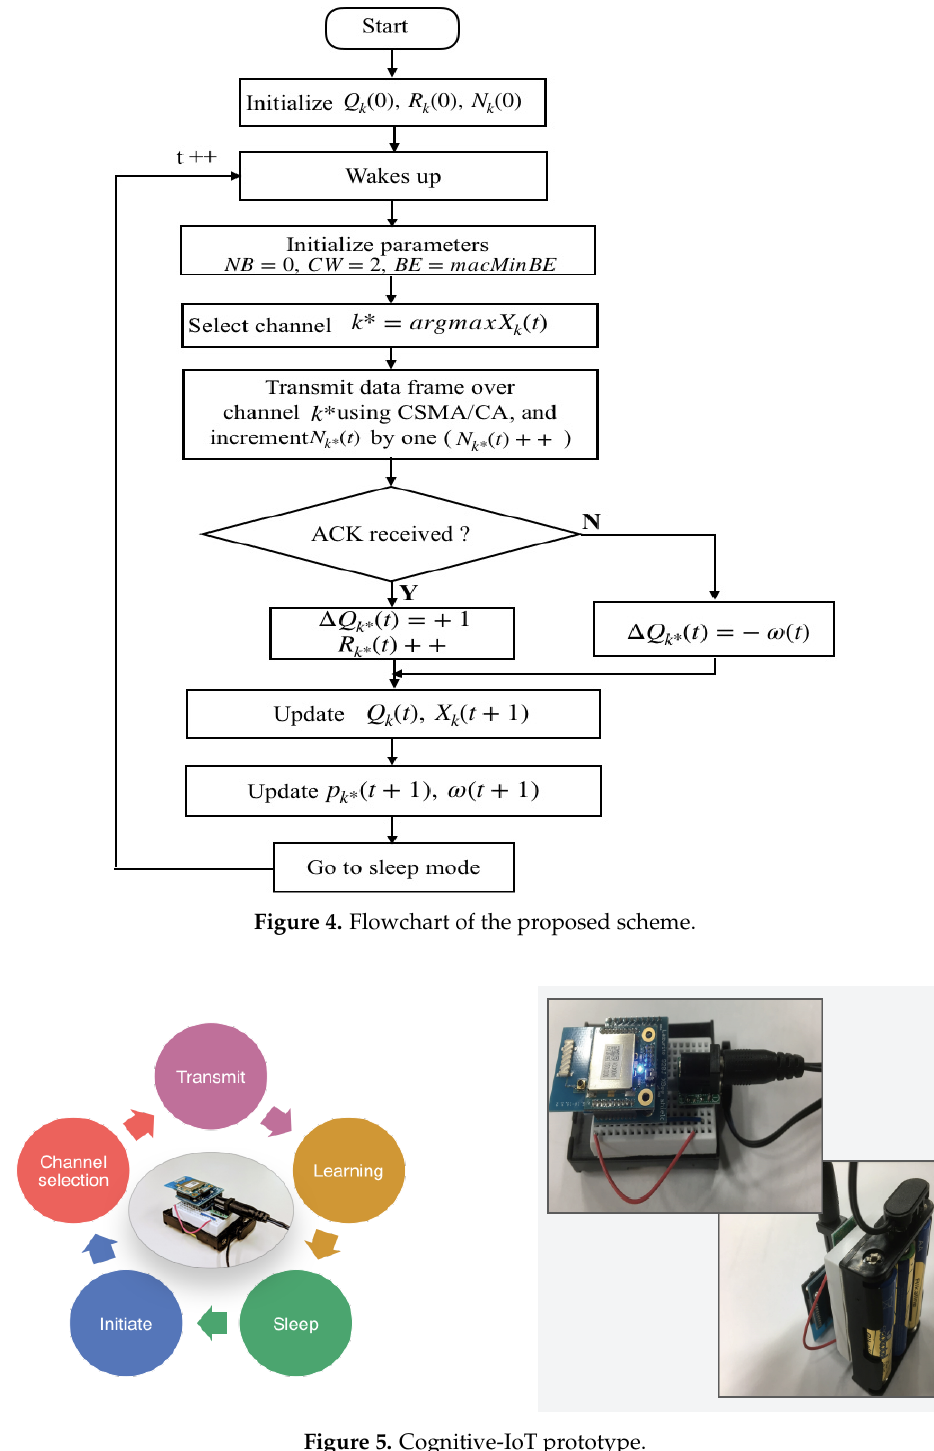
Figure 5. Cognitive-IoT